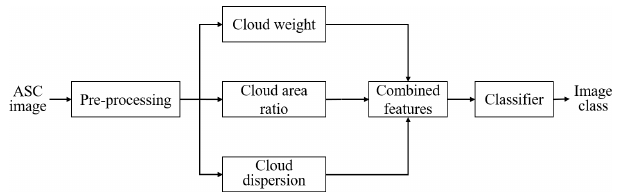
Figure 3. System